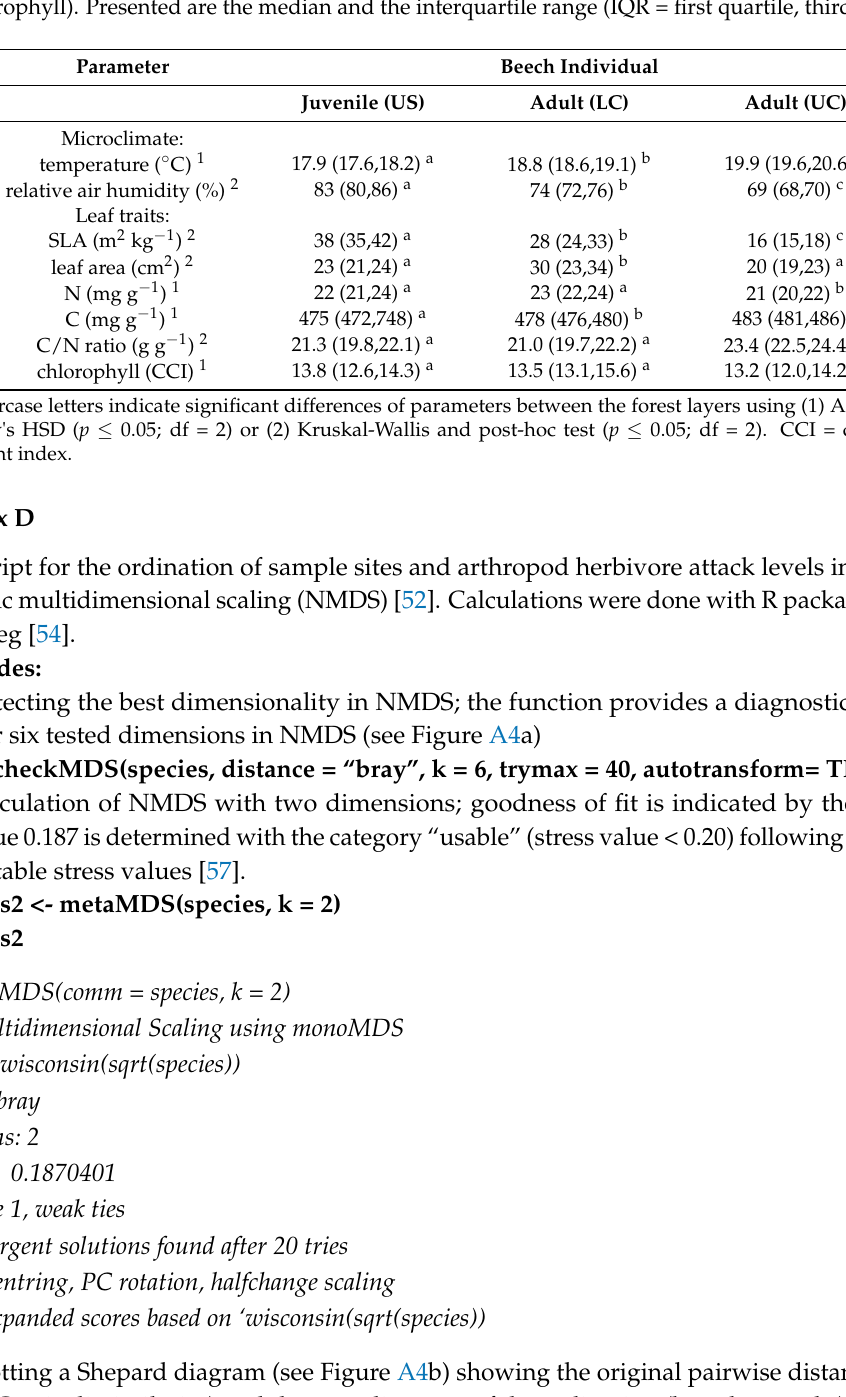
Table A2. Microclimate and leaf trait parameters of juvenile and adult Fagus sylvatica individuals along the vertical forest gradient. Microclimatic conditions for understory (US, n = 20), lower (LC, n = 20) and upper canopy (UC, n = 17) are represented by temperature and relative air humidity. Leaf trait parameters of F. sylvatica (US: n = 20; LC: n = 20; UC: n = 20) are represented by specific leaf area (SLA), total leaf carbon content (C), total leaf nitrogen content (N), C/N ratio, and chlorophyll content (chlorophyll). Presented are the median and the interquartile range (IQR = first quartile, third quartile). Parameter Beech Individual